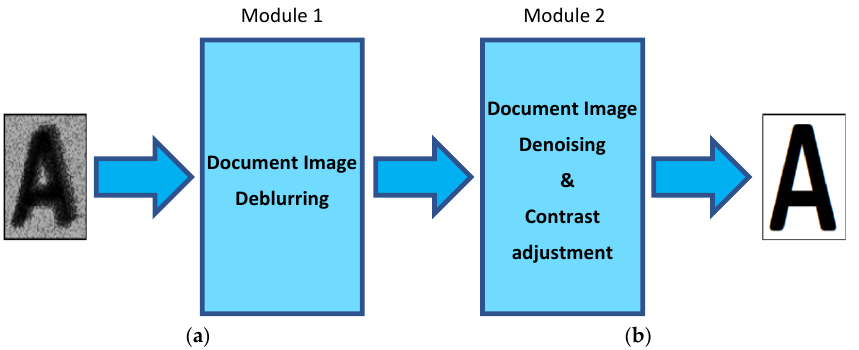
Figure 3. The novel global model is composed of ( a ) document-image deblurring (Module 1), and ( b ) document-image denoising and contrast adjustment modules (Module 2). Document-image Deblurring (Module 1, see Figure 3) and Document-Image Joint Contrast and Noise Enhancement (Module 2, See Figure 3)